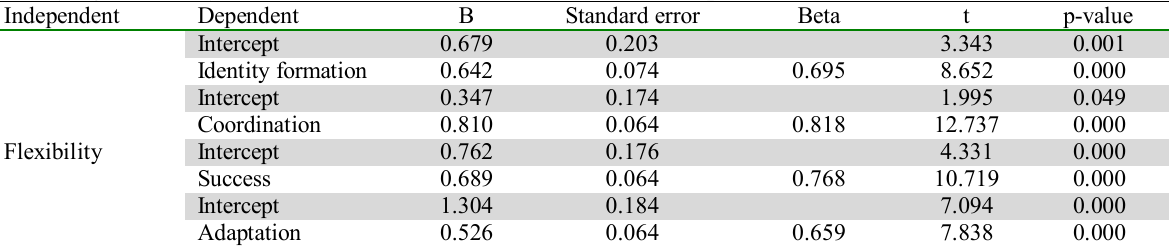
Studying flexibility and dimensions of human resource development Independent Dependent B Standard error Beta t p-value